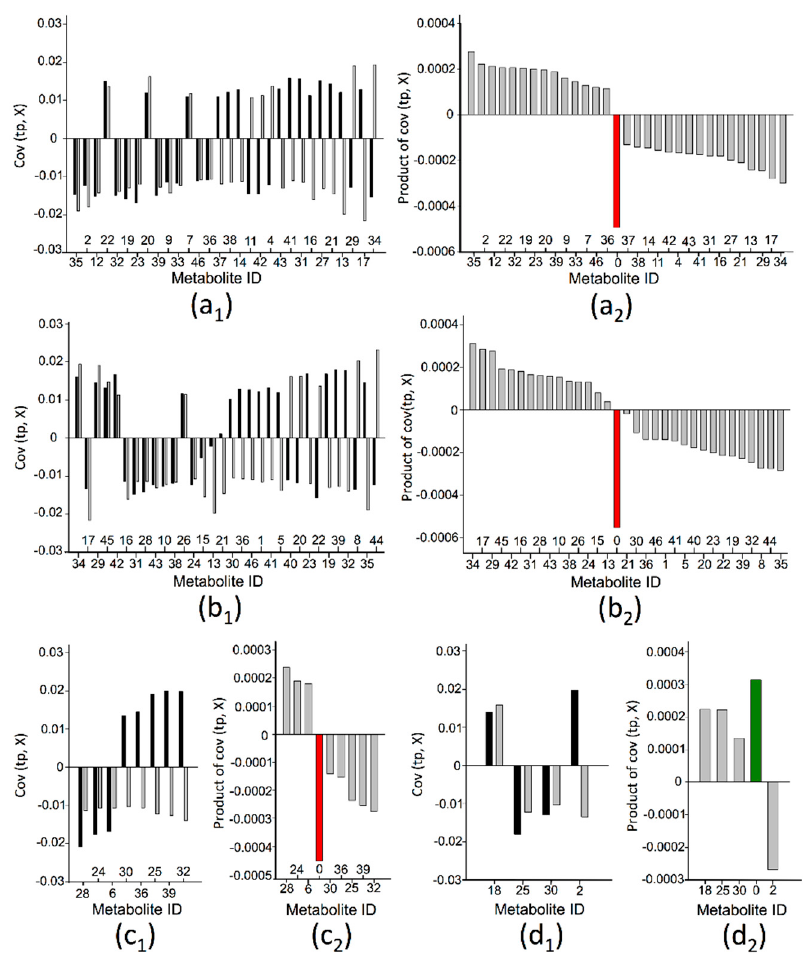
Figure 5. Individual covariance plots for: ( a 1 ) lutein; ( b 1 ) lycopene; ( c 1 ) β -carotene; and ( d 1 ) zeaxanthin. The covariance (effect) of a metabolite with respect to the carotenoid concentration is indicated in black. The covariance of a metabolite towards altered salinity is indicated in grey and was acquired from the OPLS-DA models, discriminating between the EC-treatments of 2.0 and 5.0 dS m − 1 . Individual plots of covariance products for: ( a 2 ) lutein; ( b 2 ) lycopene; ( c 2 ) β -carotene; and ( d 2 ) zeaxanthin. The metabolite with ID zero represents the sum of all covariance product functions. Red color indicates a total negative outcome and green color a total positive outcome.